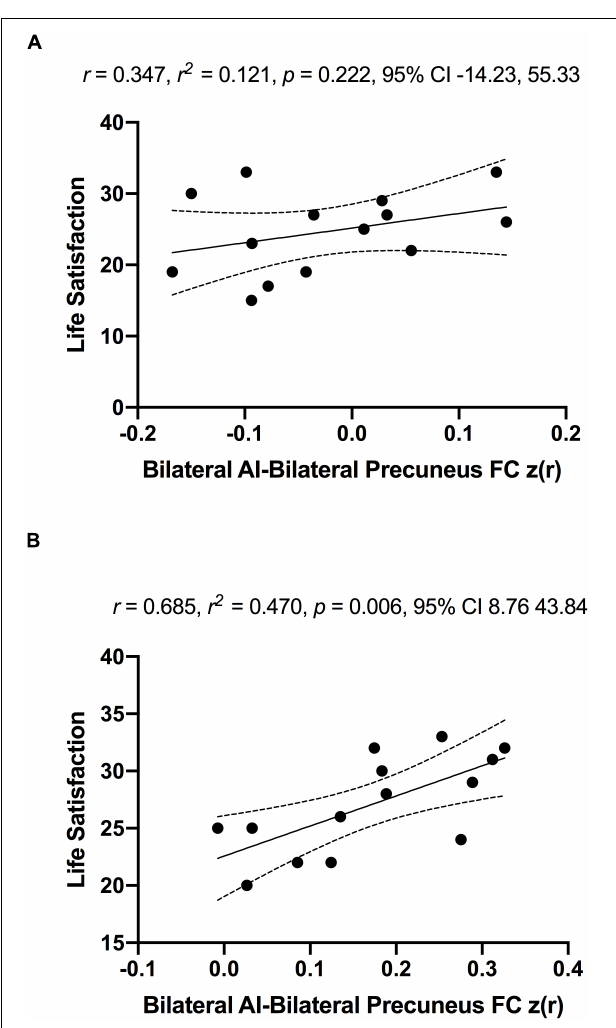
FIGURE 6 | No significant associations between anterior insula-FC and life satisfaction scale in MCI individuals before (Panel A ) and significantly positive association after exercise training (Panel B ). The r , r 2 , p -value, and 95% confidence interval reflect the correlation of anterior insula-FC and life satisfaction and dotted curves indicate 95% confidence interval around the regression